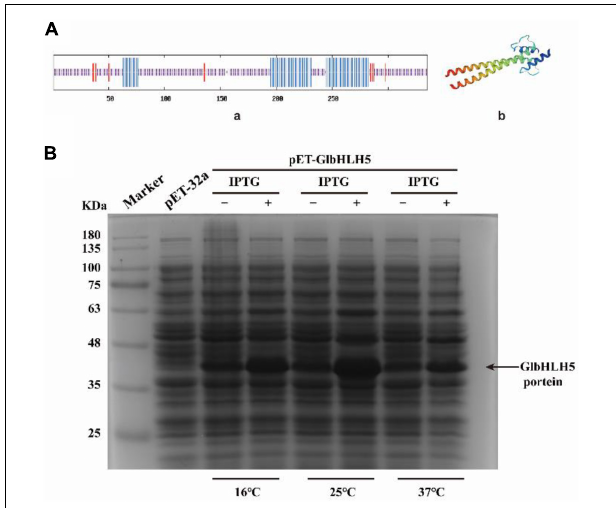
FIGURE 2 | Structure prediction and prokaryotic expression of GlbHLH5 protein. (A) Secondary (a) and three-dimensional (b) structure prediction of GlbHLH5 Protein. (B) Prokaryotic expression of GlbHLH5 Protein.